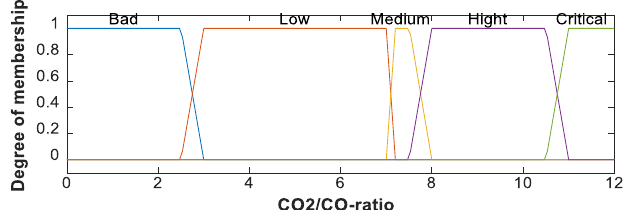
Figure 2. Membership functions for CO2/CO ratio.